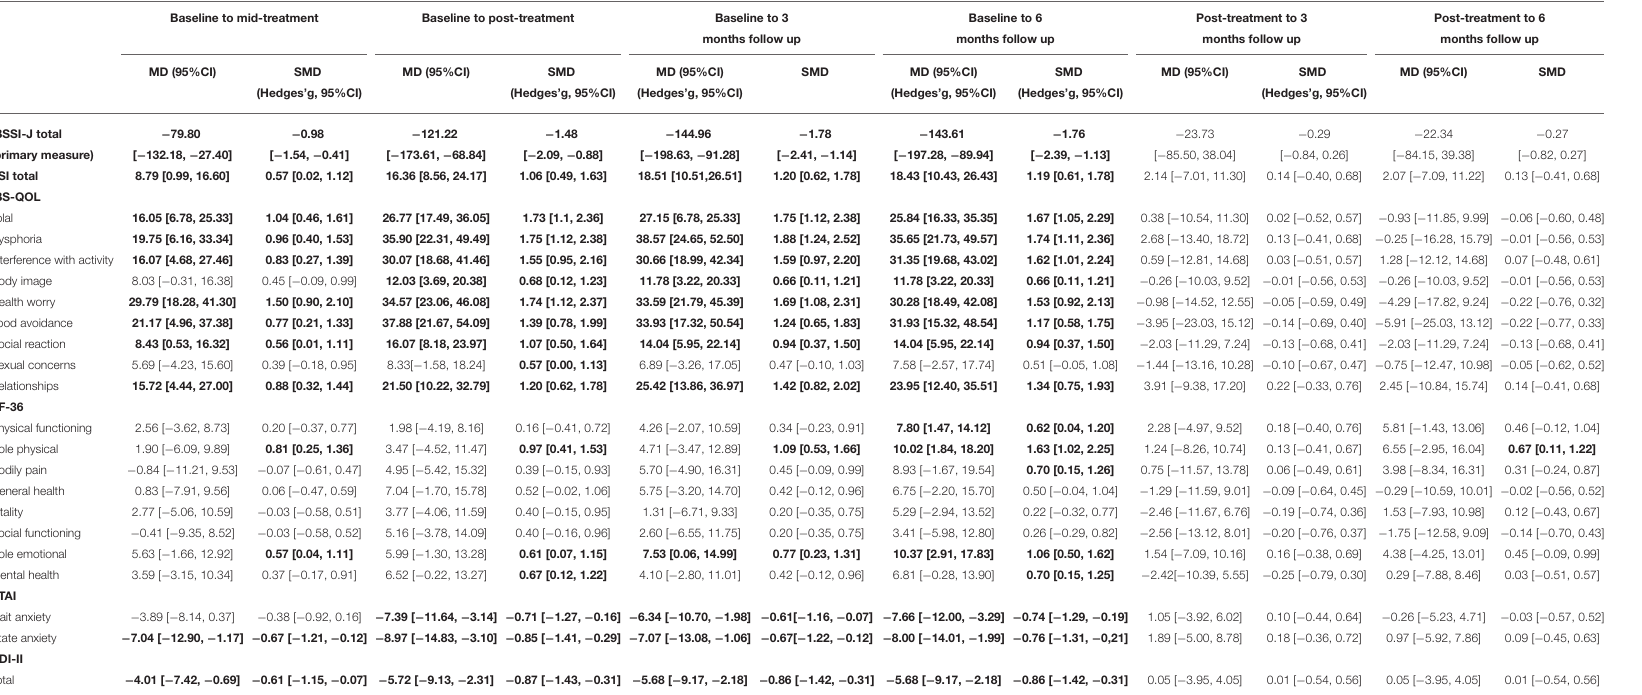
TABLE 5 | Estimated mean difference and standardized mean difference with 95% confidence interval LMM.